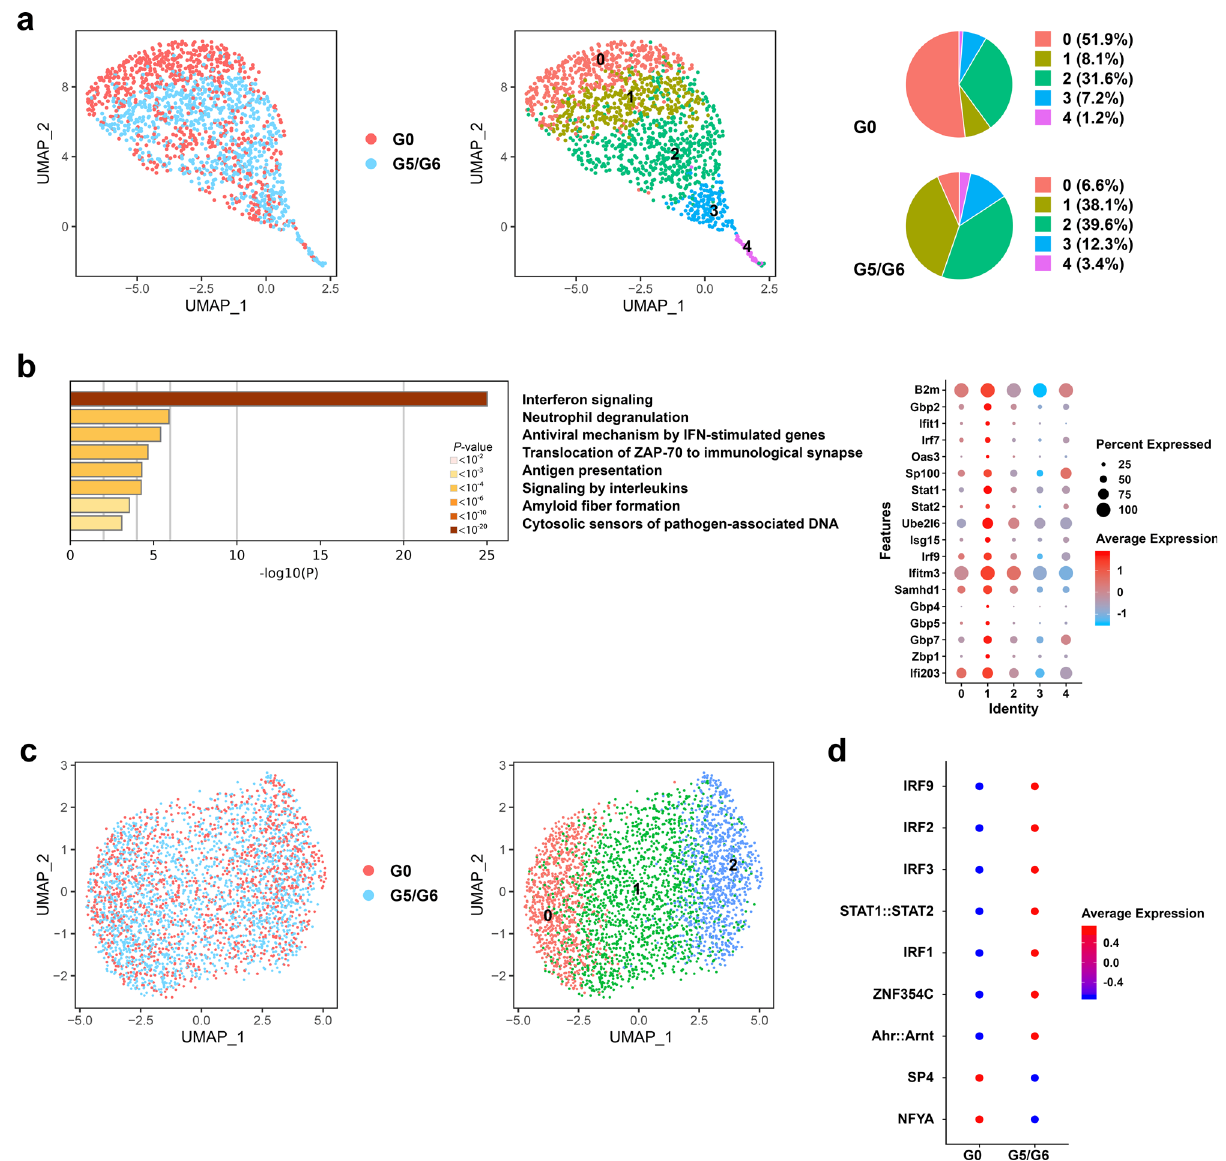
Fig. 2 HSCs with short telomeres are persistently activated, overexpress genes involved in IFN signaling, and are poised towards megakaryocytic differentiation. a UMAP of scRNA-seq data displaying 752 and 816 pooled single HSCs isolated from G0 or G5/G6 mice, respectively ( n ≥ 2 mice per group). Each dot represents one cell. Different colors represent the sample (left) and cluster (middle) identities. Right, the distribution of HSCs from G0 and G5/G6 mice among the fi ve scRNA-seq clusters, represented as the percentages of cells belonging to each cluster. b Left, pathway enrichment analysis of the marker genes of cluster 1 shown in Fig. 2a and Supplementary Dataset 3 (adjusted P ≤ 0.05). The Reactome gene sets are shown. Right, the dot plot shows the differential expression of the genes involved in IFN signaling across the fi ve HSC clusters. c UMAP of scATAC-seq data displaying 1416 and 2046 pooled single HSCs isolated from G0 or G5/G6 mice, respectively ( n ≥ 9 mice per group). Each dot represents one cell. Different colors indicate the sample origins (left) and cluster identities (right). d Dot plot of the level of the activities of the TFs whose binding sites were differentially enriched in the open chromatin regions of G5/G6 cells from cluster 0 as compared to those enriched in the open chromatin regions of G0 cells. Source data are provided as a Source Data fi